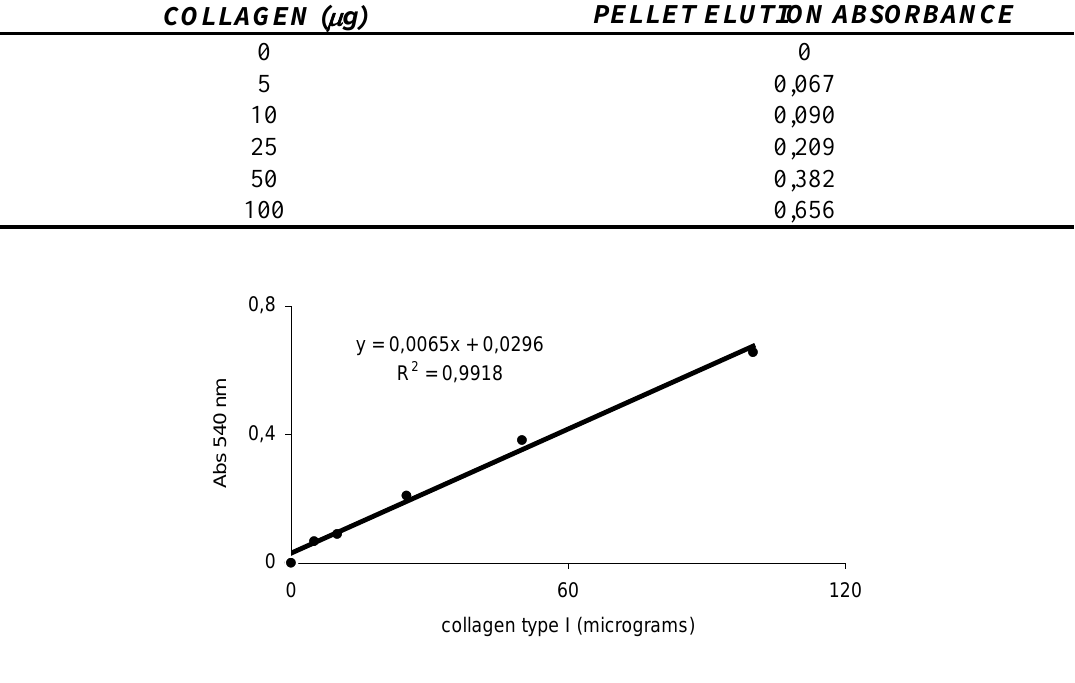
FIGURE 3 - Standard curve of absorbance (540 nm) of the eluted from the collagen precipitation reaction with the dye Sirius Red (collagen type I from rat tail soluble in acetic acid.